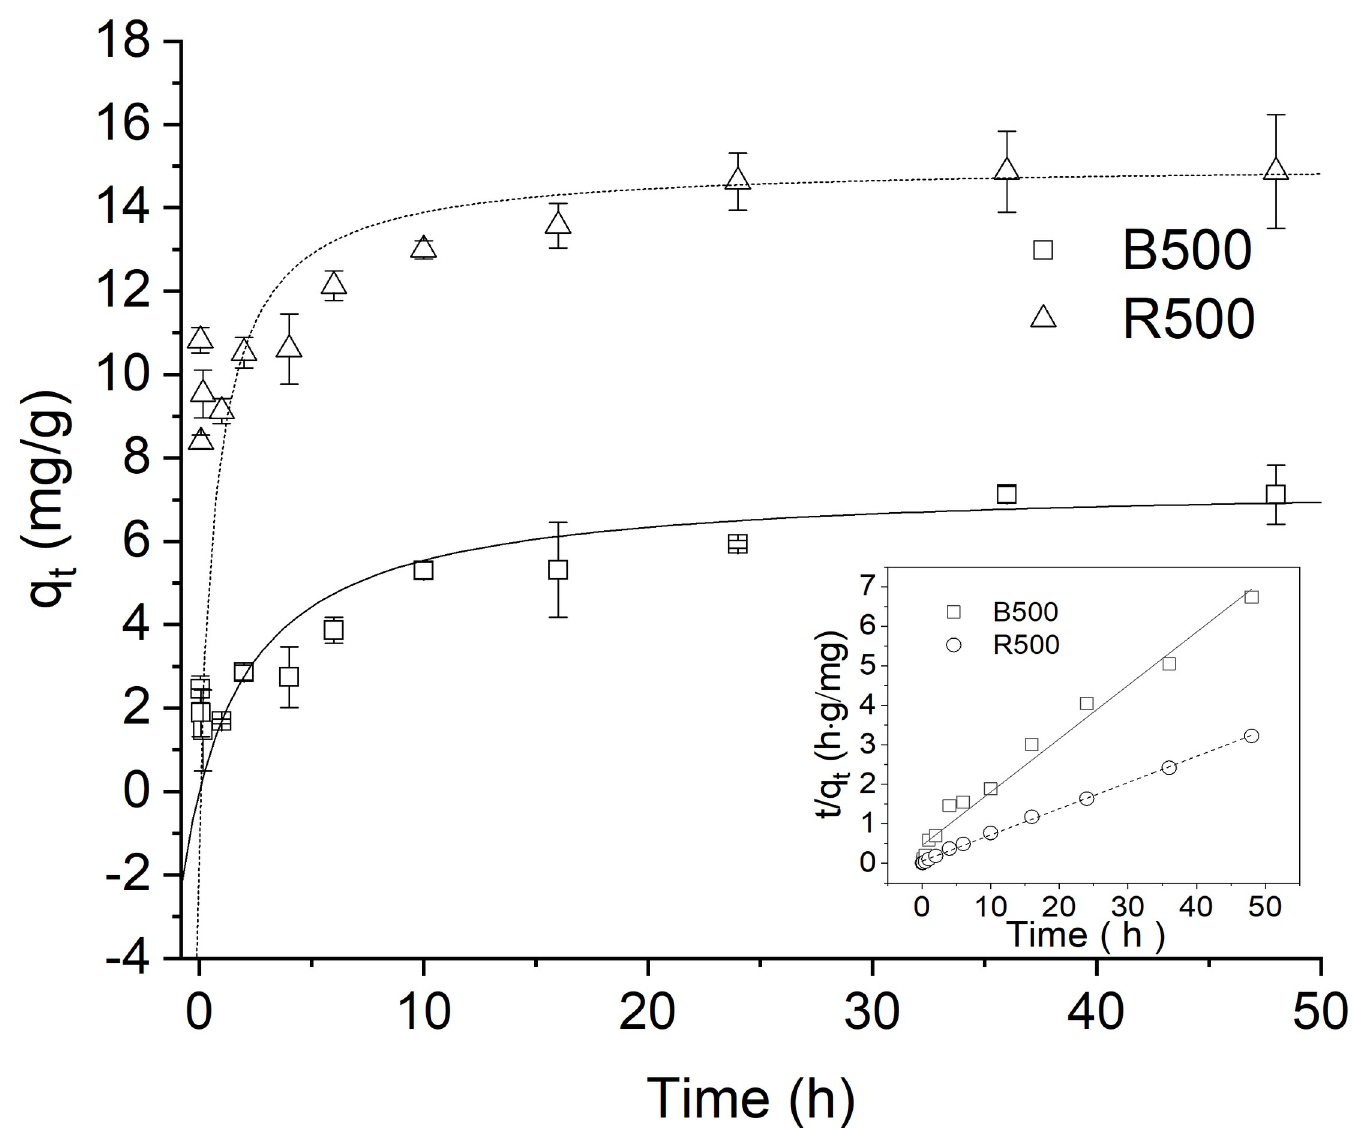
Fig 4. Adsorption kinetics (pseudo-second-order model) of BR46 on B500 and R500 (pH = 7.0). The insert is the linear plot of the pseudo-second-order model fit. Error bars indicate the SD.